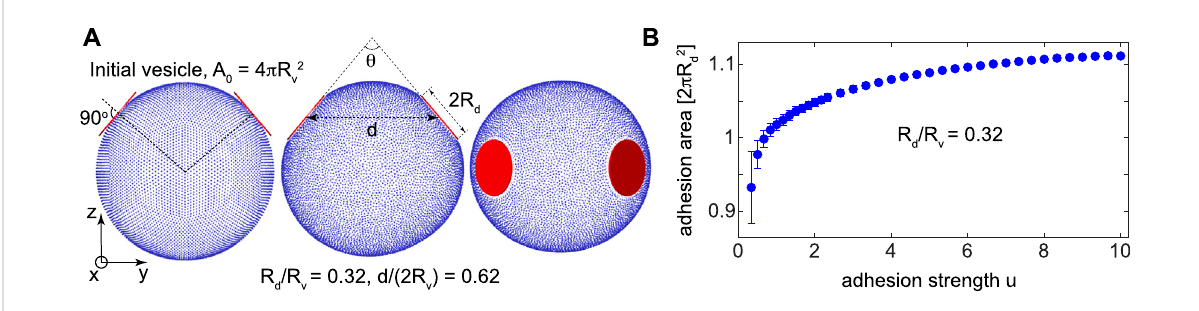
FIGURE 1 The initial spherical vesicle of fi xed area A 0 (cid:1) 4 π R 2 v with two fl at disks of size R d / R v =0.32 located initially tangent to the vesicle surface at a distance d /(2 R v )=0.62 in the left panel of (A) , evolves to a fi nal low-temperature vesicle with fully adsorbed disks in the strong adhesion limit in the mid panel of (A) . The relative angular position of the disks is de fi ned by θ as seen for the minimum-energy vesicle at low temperature, front and top views in the middle and right panels of (A) . (B) The two disks of size R d / R v =0.32 are fully adhered to the vesicle in the strong adhesion limit with suf fi ciently-large adhesion strength u =10. Each point re fl ects the mean and the standard deviation of the adhesion area from ten